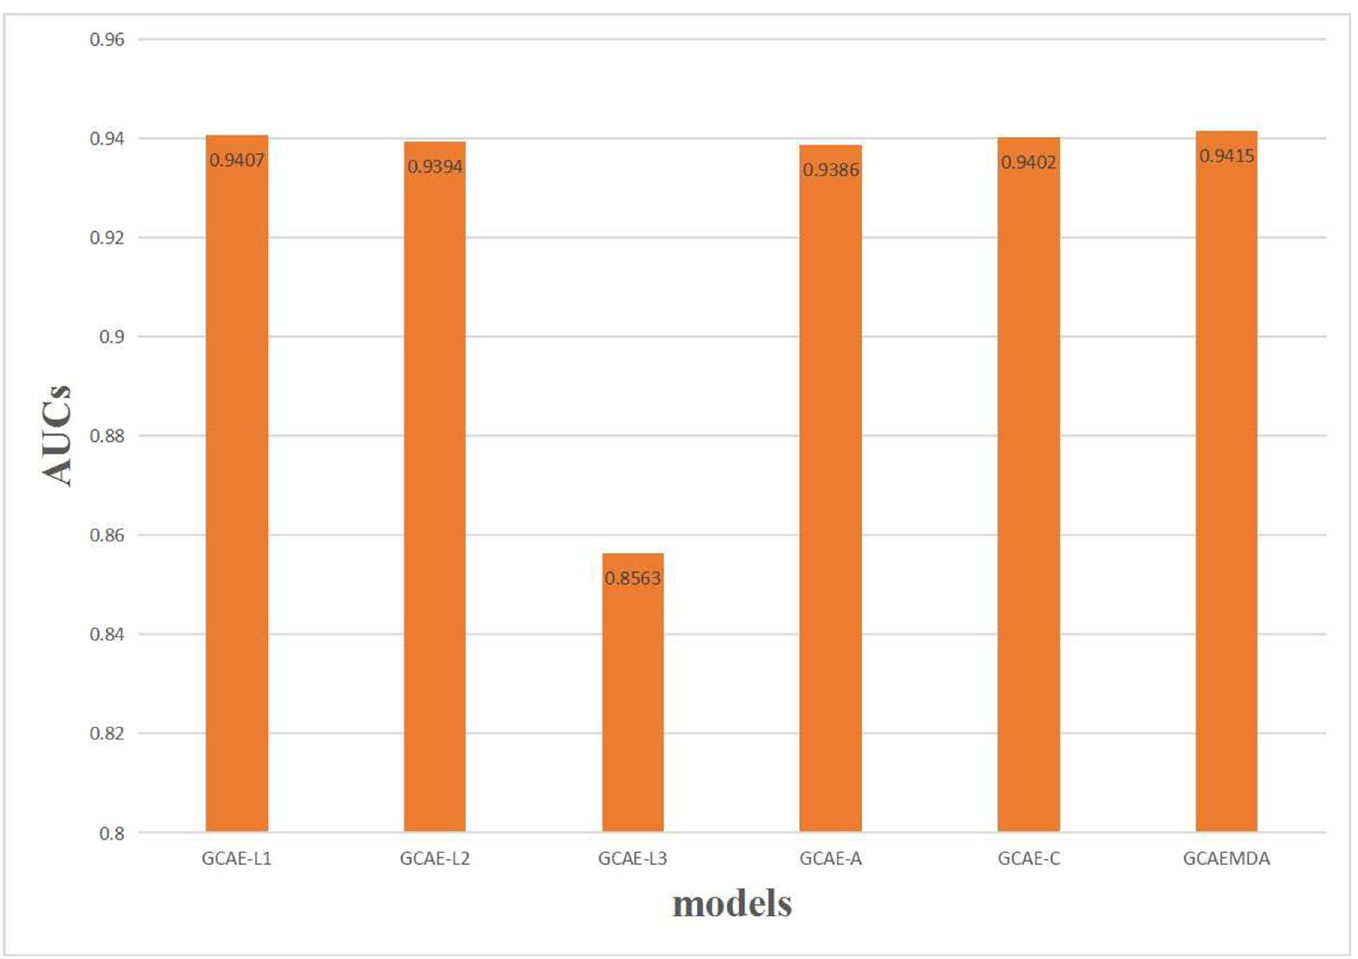
Fig 8. Performance of GCAEMDA based on different